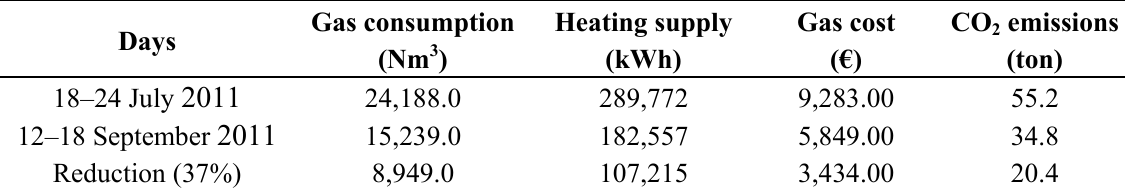
Table 4. Energy, cost, and emissions during the week.